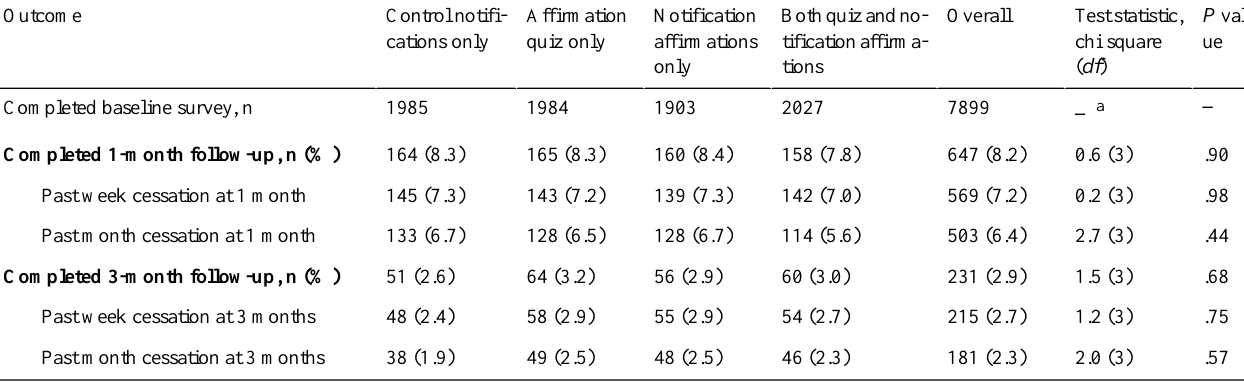
Table 2. Attrition and cessation rates by study condition (N=7899).